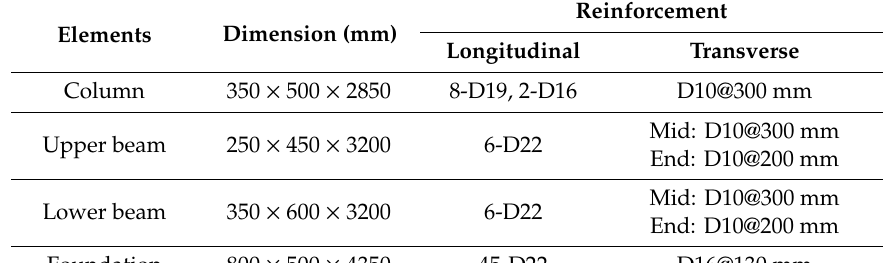
Table 1. Details of the specimens.